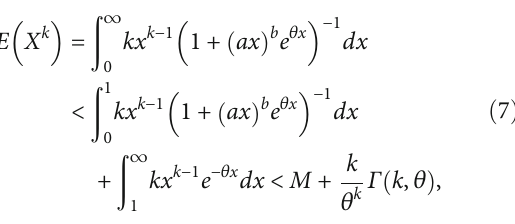
Table 1: The bias and MSE of the ML and LLP estimators computed by a simulation study. Each cell consists of B and MSE in the second row, and B θ and MSE θ in the third row, B b b